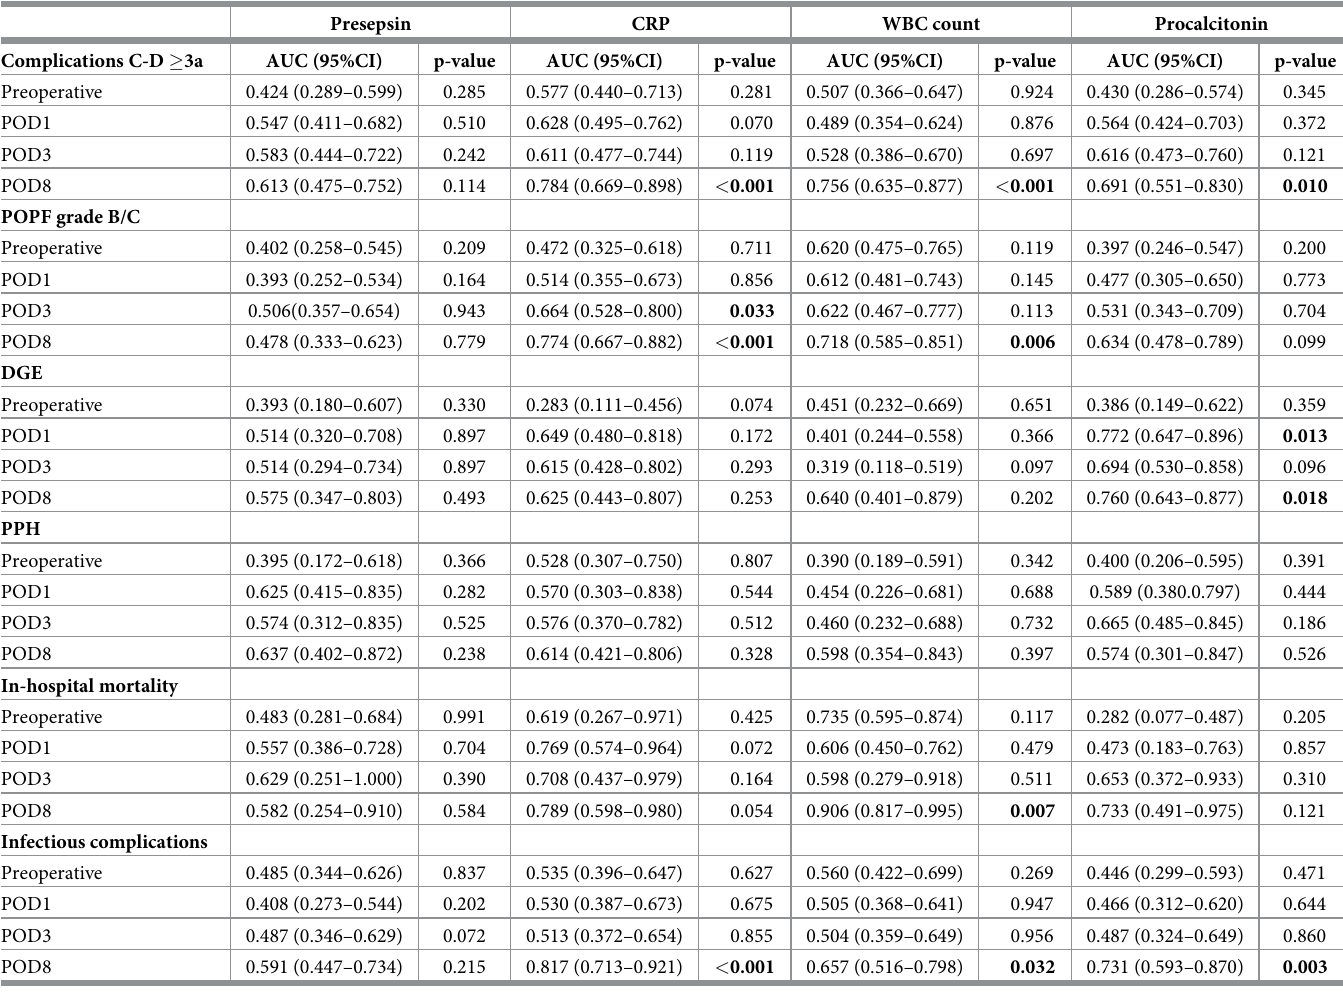
Table 3. Presepsin, CRP, WBC count and procalcitonin and their predictive value for development of complications Clavien-Dindo � 3a, POPF grade B/C, DGE, PPH, in-hospital mortality and infectious